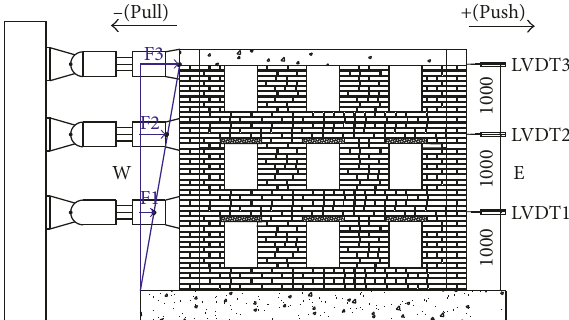
Figure 4: Loading scheme and instrumentations.